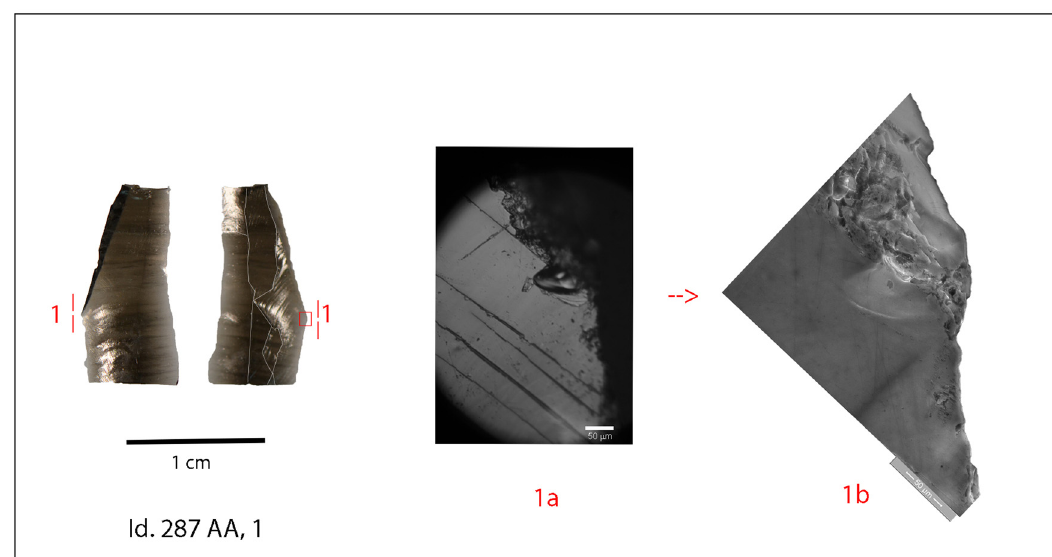
Figure 5: Id. 287 AA, 1. Use - wear observed with re fl ected - light optical microscope ( OM 200 ×) ( 1a ) and SEM ( 1b ) . Particular of the same scar with feather